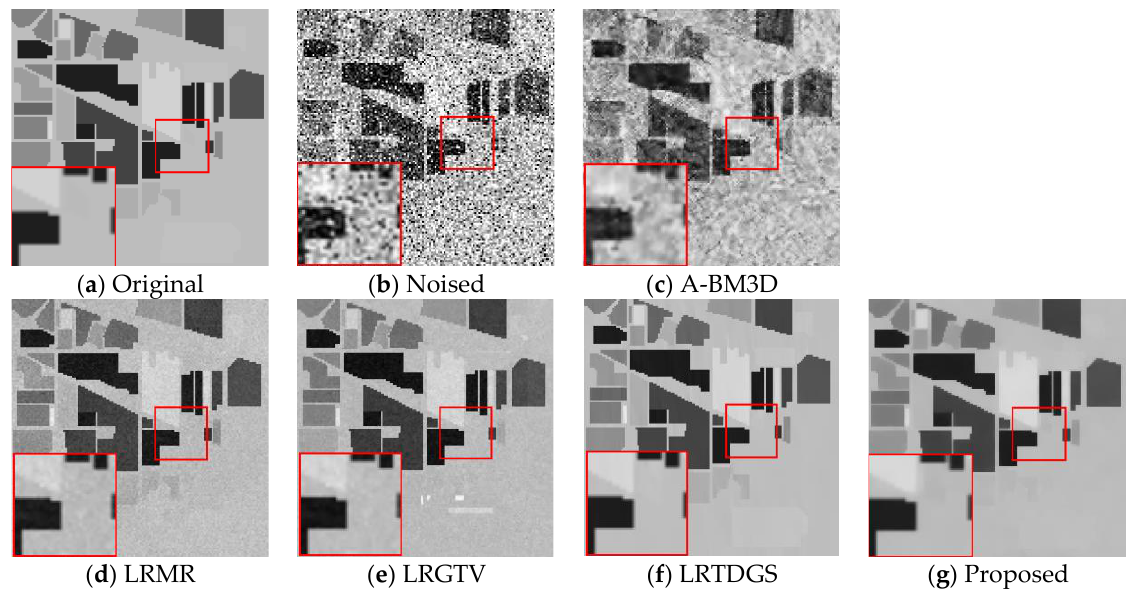
Figure 2. Restored results of band 57 on Simu–Indian. From top to bottom: the results under a subcase (the standard deviation of zero-mean Gaussian noise is G = 0.10, and the noise proportion of S&P noise is S = 0.20).